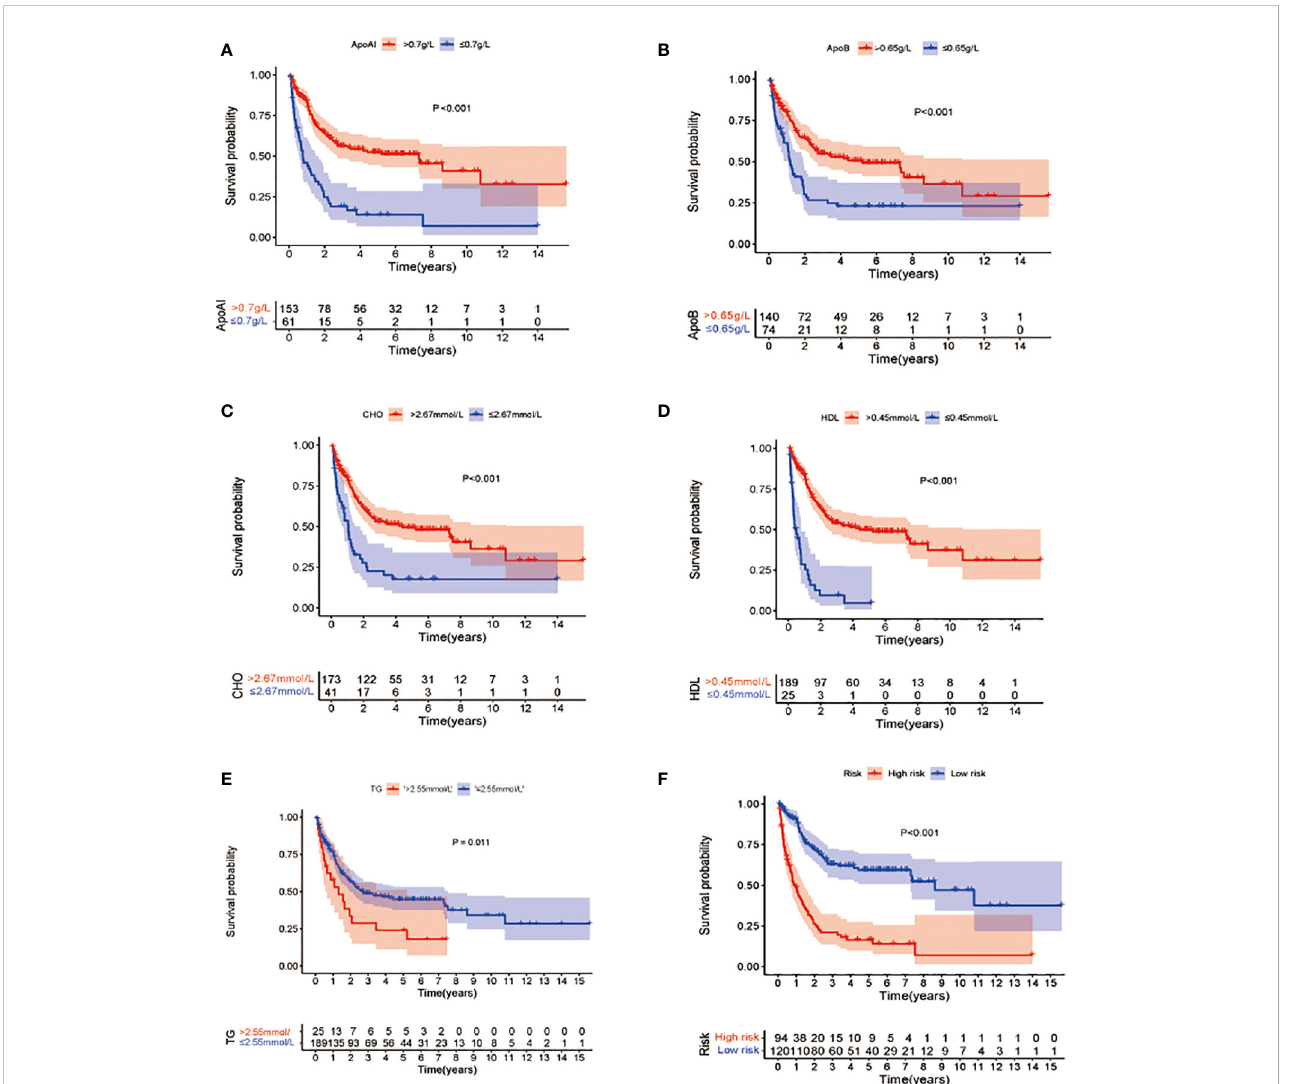
FIGURE 2 Kaplan-Meier survival analysis of overall survival between patients groups with low and high levels of lipid pro fi le biomarkers (A – E) . (A) OS strati fi ed by the level of Apo A-I ≤ 0.7 vs >0.7 g/L (p<0.001). (B) : OS strati fi ed by the level of Apo B ≤ 0.65 vs >0.65 g/L (p<0.001). (C) OS strati fi ed by the level of CHO ≤ 2.67 vs >2.67 mmol/L(p<0.001). (D) OS strati fi ed by the level of HDL ≤ 0.45 vs >0.45 mmol/L (p <0.001). (E) OS strati fi ed by the level of TG ≤ 2.55 vs >2.55 mmol/L (p<0.001). (F) Survival differences between high- and low-risk groups in the whole